Question: Identify the chart type used in this figure.
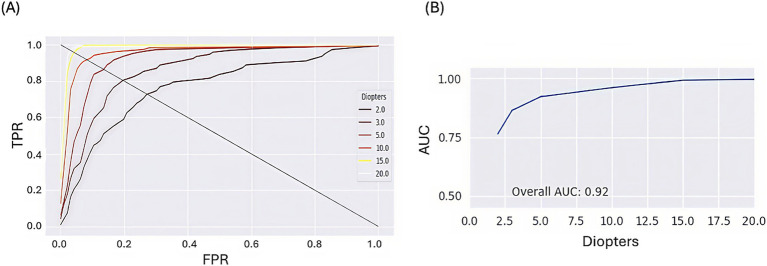
Answer: line